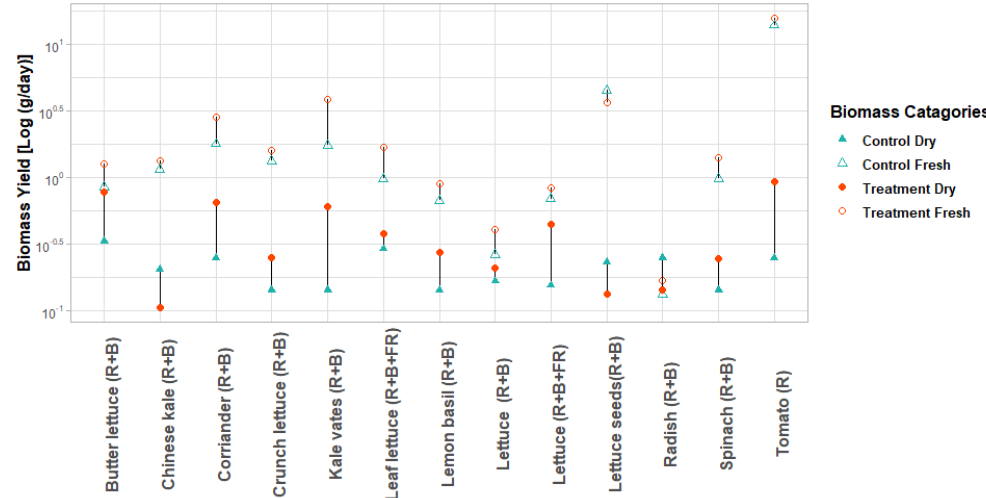
Figure 4. Effect of different LED illumination spectra on plant growth and development parameters, treatment fresh mass and treatment dry mass (with LED illumination), control fresh mass, and control dry mass (without LED illumination) for different vegetables and herbs grown in the growth chamber. Plants traits were log-transformed due to considerable variation in different treatments among